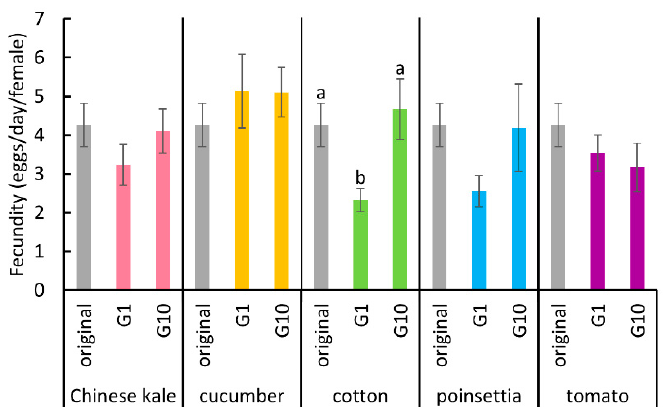
Figure 3. The fecundity of B. tabaci reared on each host plant in the first and tenth generations, and the original colony. Vertical bars indicate standard errors. Different letters indicate significant differences (Dunn’s test, p < 0.05).